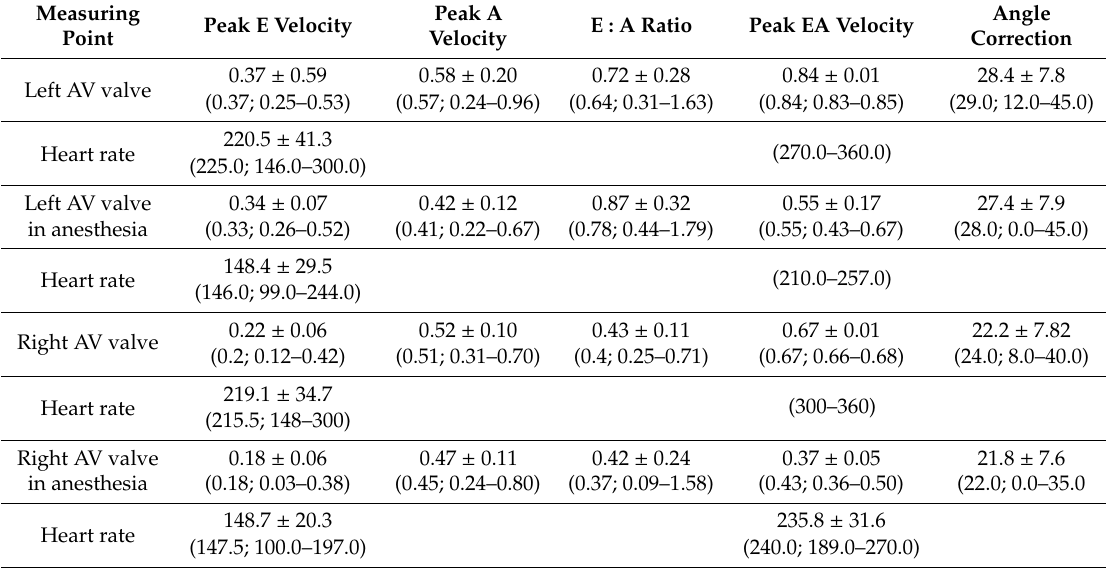
Table 1. Diastolic ventricular filling velocities (m / s) of conscious and anaesthetized healthy racing pigeon (mean ± standard deviation; median; and Xmin–Xmax).